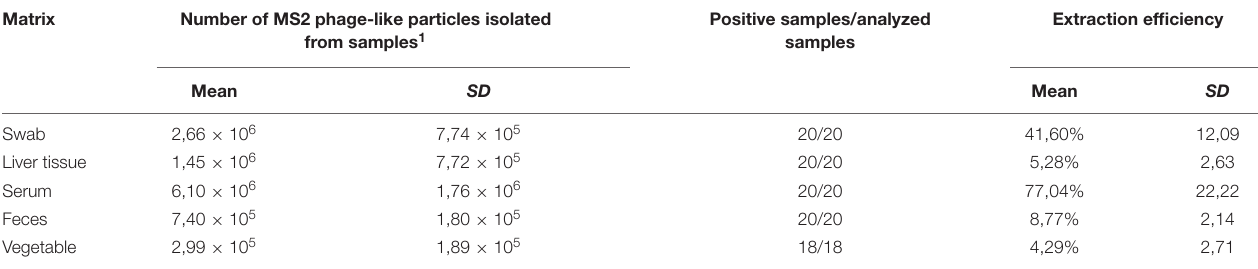
TABLE 3 | Extraction efficiency of MS2 phage-like particles (MS2 PLP) isolated from different types of matrices artificially contaminated with 5 × 10 6 MS2 PLP per sample.